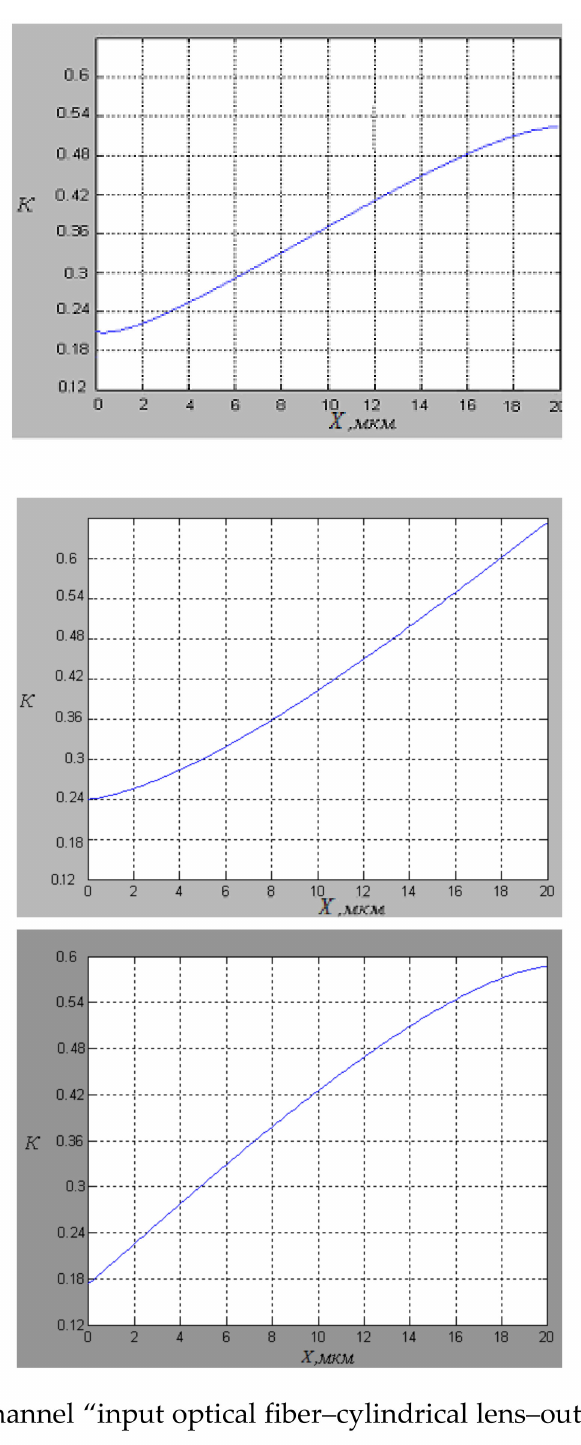
Figure 5. The main results of modeling an optical system at various variations of the distances “input optical fiber – cylindrical lens – output optical fiber”, ( a ) l 2 = 1.1 mm, ( b ) l 2 = 1.3 mm, ( c ) l 2 = 1.5